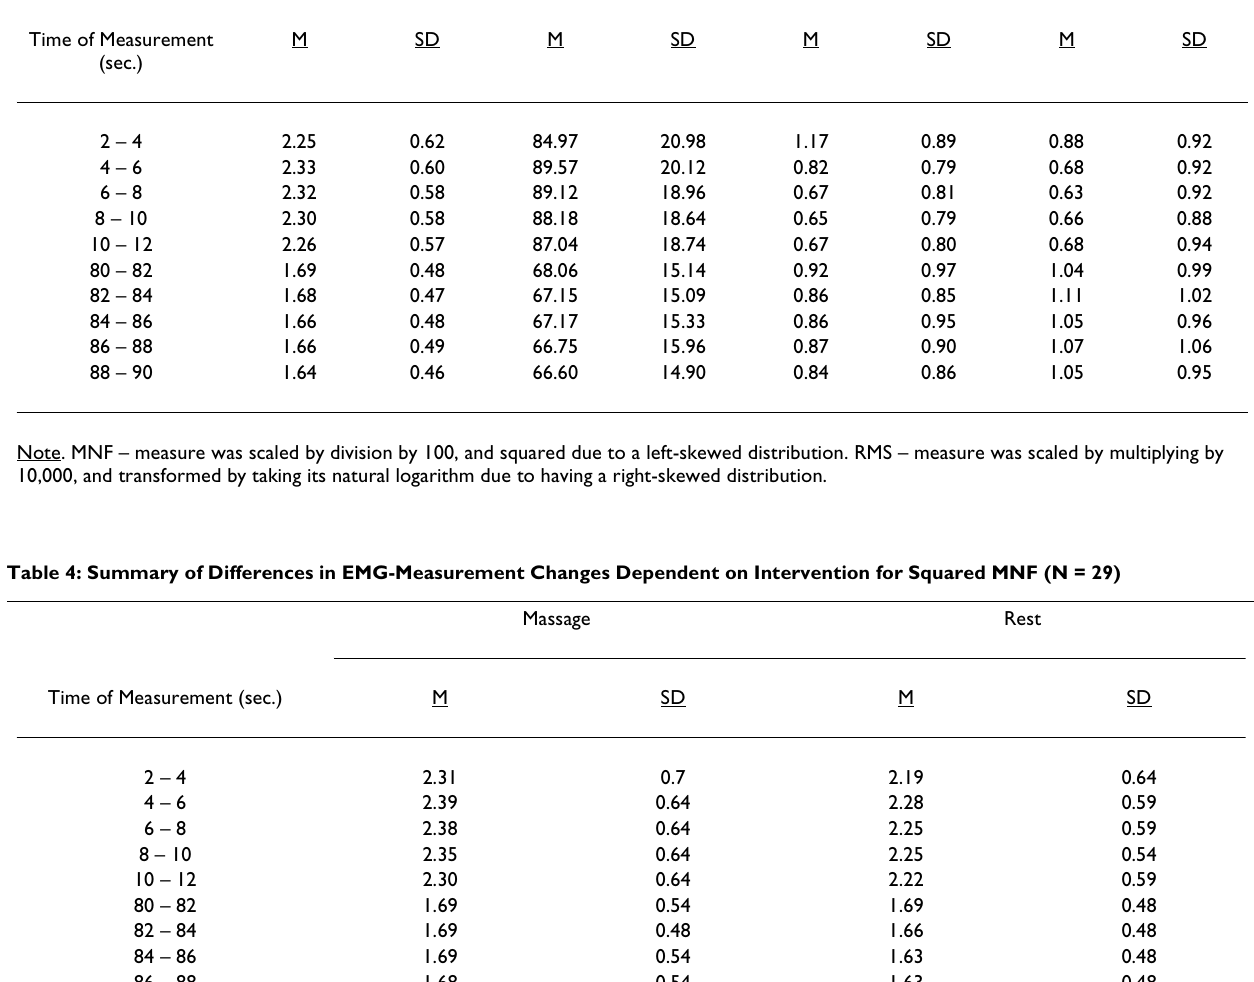
Before Intervention